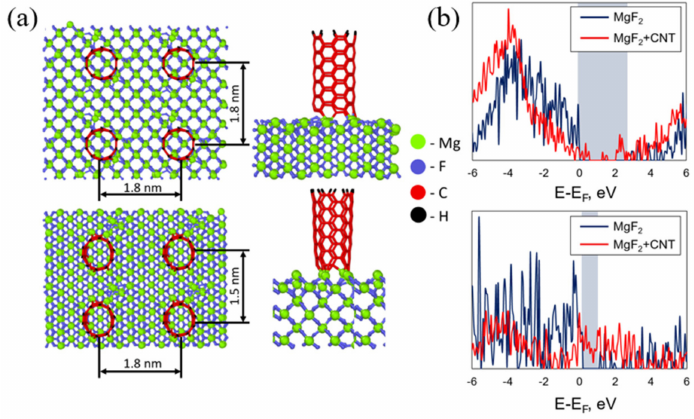
Figure 3. ( a ) Atomic structure of the considered CNT/MgF 2 interfaces. ( b ) Electronic density of states. Blue and red curves indicate pristine and modified MgF 2 , respectively.